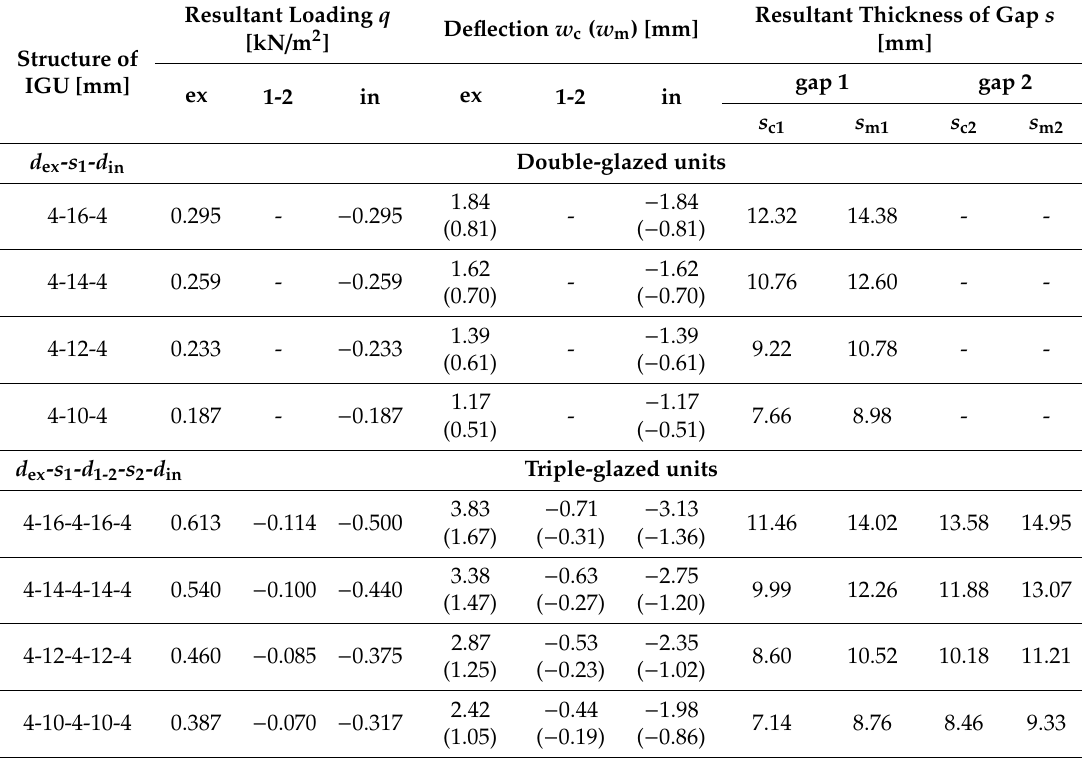
Table 3. Static quantities and gap thicknesses in IGUs under reduced temperature conditions (Variant 1) and atmospheric pressure increase by ∆ p = 3